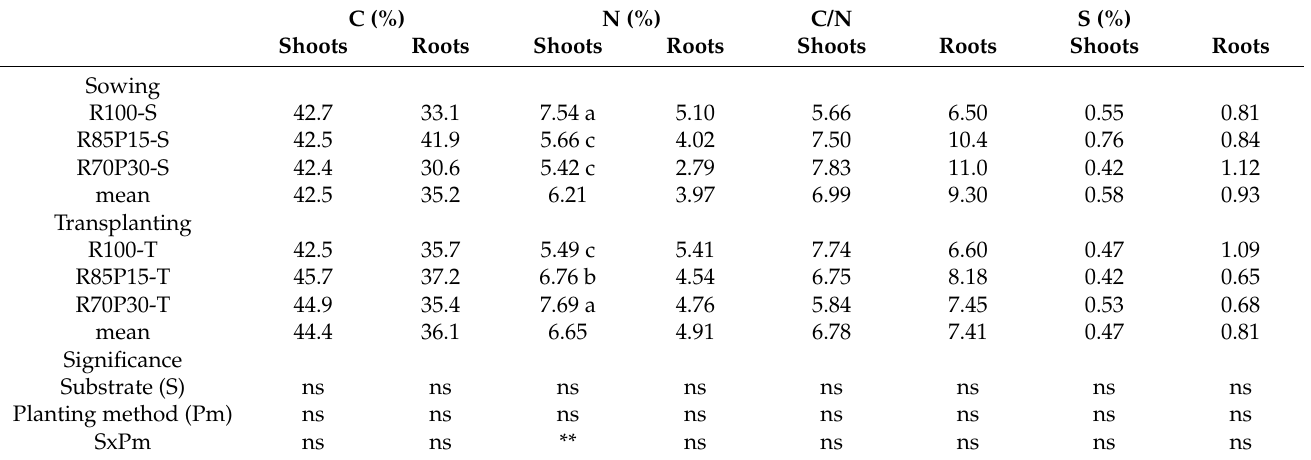
Table 2. Elemental analysis (C, N, S, and C/N ratio) in shoots and roots of soybean cultivar ‘Pr91M10 (cid:48) grown on Mojave Mars Simulant MMS-1 (R100) alone and in mixture with peat at two different rates ( v : v ), 85:15 (R85P15) and 70:30 (R70P30), from direct sowing on the different substrates and from transplanting after germination on peat. 20 DAS; Mean values, n = 4; ns, ** indicate non-significant or significant difference at p < 0.01, respectively (two-way ANOVA, Duncan’s multiple-range